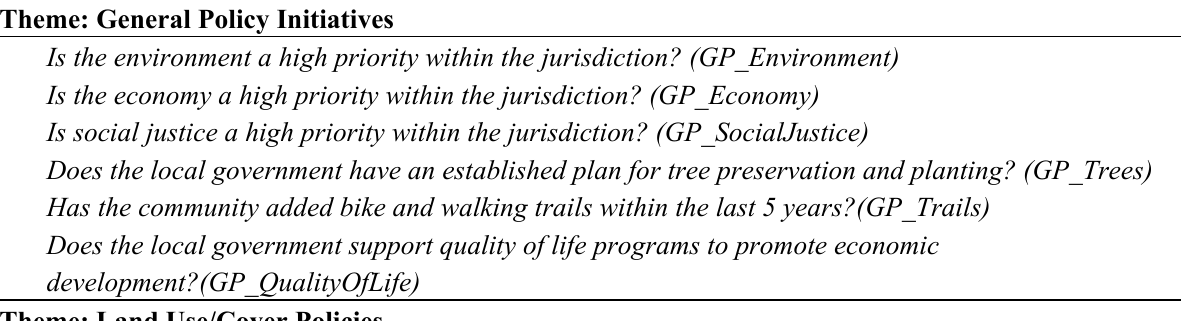
Table 1. Survey questions from the ICMA sustainability and economic surveys used to assess economic characteristics and policy priorities for each of the 373 US